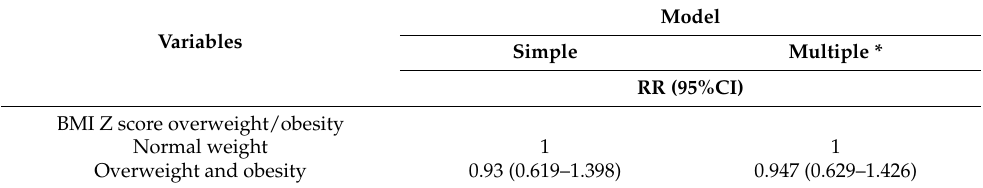
Table 5. Relative risk and 95% CI for having a low score on the Adolescent Food Habit Checklist ( n =